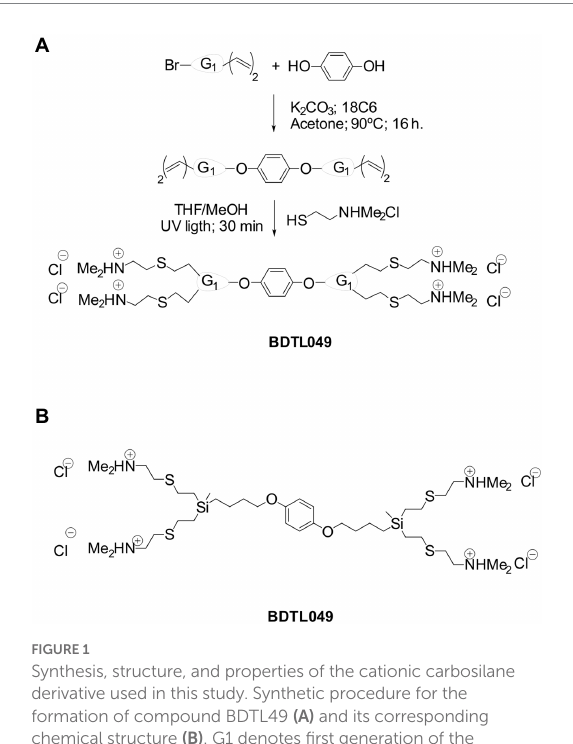
FIGURE 1 Synthesis, structure, and properties of the cationic carbosilane derivative used in this study. Synthetic procedure for the formation of compound BDTL49 (A) and its corresponding chemical structure (B) . G1 denotes first generation of the carbosilane scaffold. Molecular weight of 964 Daltons. The compound is air and water stable, soluble in protic solvents like water or methanol, and non-soluble in organic